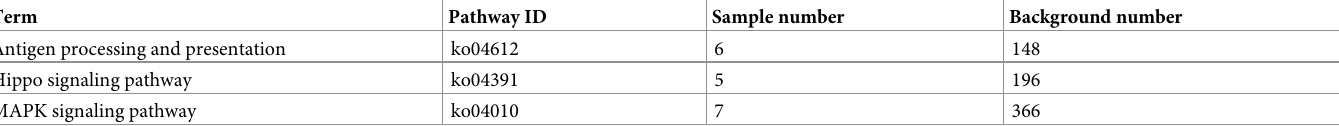
Table 4. KEGG Enrichment of DEGs.